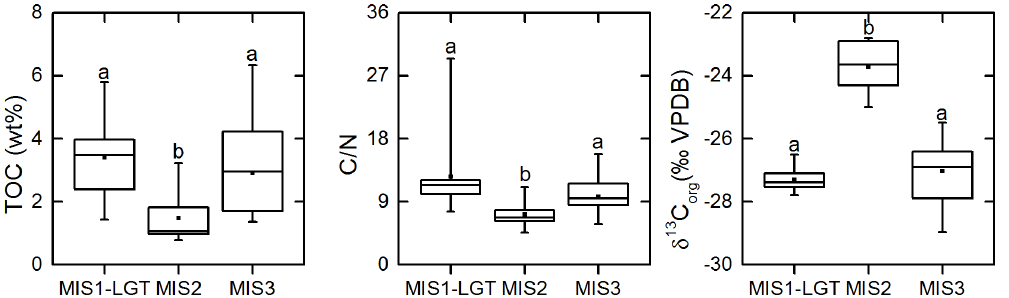
Figure 2. Box plot of total organic carbon (TOC), total organic carbon to total nitrogen ratio (C / N), and δ 13 C org values of permafrost deposits from the MUO12 sequence, the BK8 core, and the two L14 cores from the Holocene interglacial (MIS 1), including the late glacial transition (LGT) ( n = 12), the Sartan stadial (MIS 2) ( n = 6), and the Kargin interstadial (MIS 3) ( n = 27). The whiskers show the data range and the box indicates the interquartile range. The vertical line and square inside the boxes show the median and mean, respectively. The letters above the whiskers indicate statistically significant differences in geochemical characteristics between the deposits of different ages (Mann–Whitney test, p< 0 . 016 for TOC and C / N, p< 0 . 001 for δ 13 C org ) .